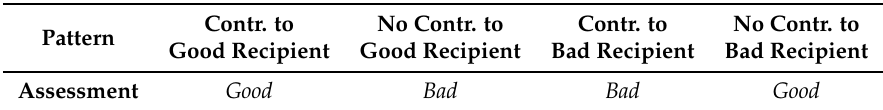
Table 1. Contribution patterns under stern-judging